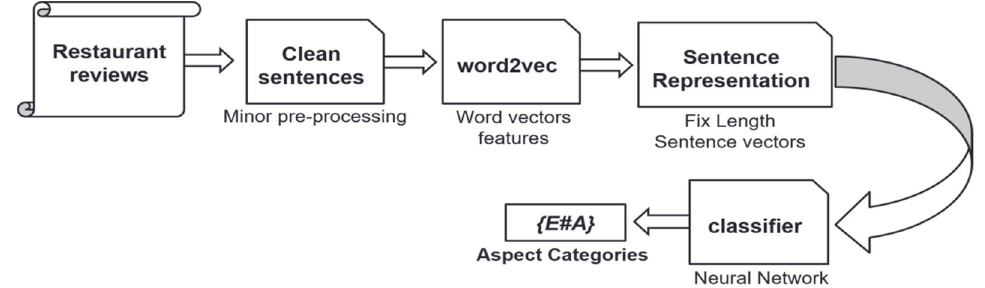
Figure 1. System architecture of aspect category detection (ACD).